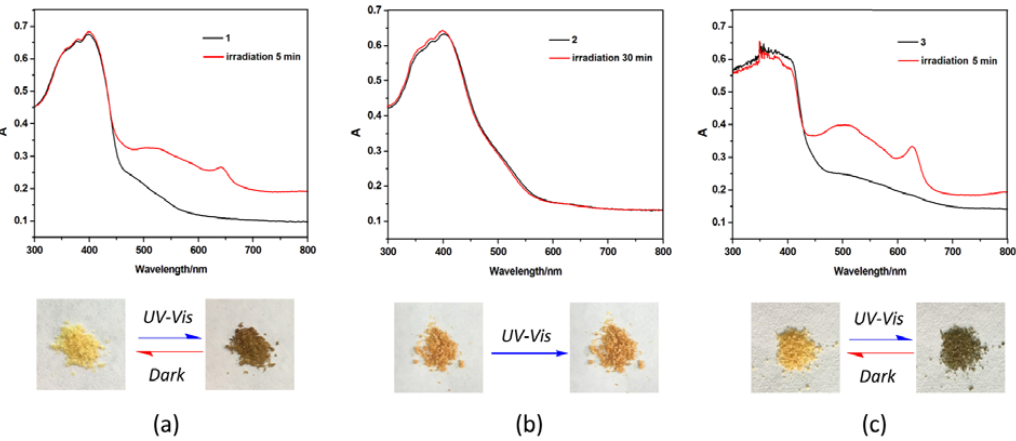
Figure 4. UV − Vis diffuse reflectance spectra of 1 – 3 before and after irradiation ( upper, 1 ( a ) , 2 ( b ) , 3 ( c )); photographs showing the photochromic behavior of 1 – 3 ( bottom ).